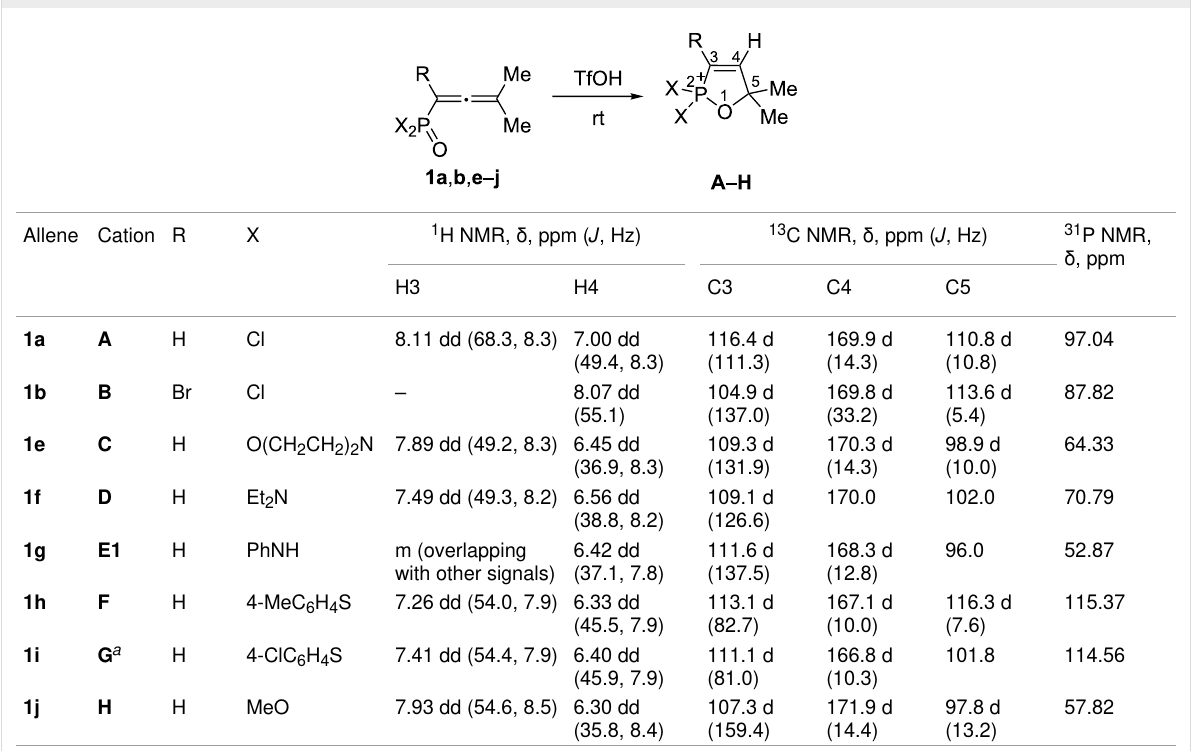
Table 1: Selected 1 H, 13 C and 31 P NMR data for cations A–H derived from the protonation of the corresponding allenes 1a , b , e–j in TfOH at room temperature.